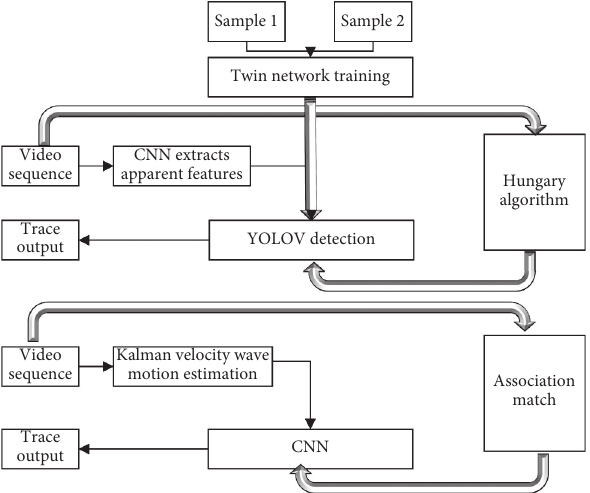
Figure 4: Framework diagram of a motion tracking method in- corporating apparent features.